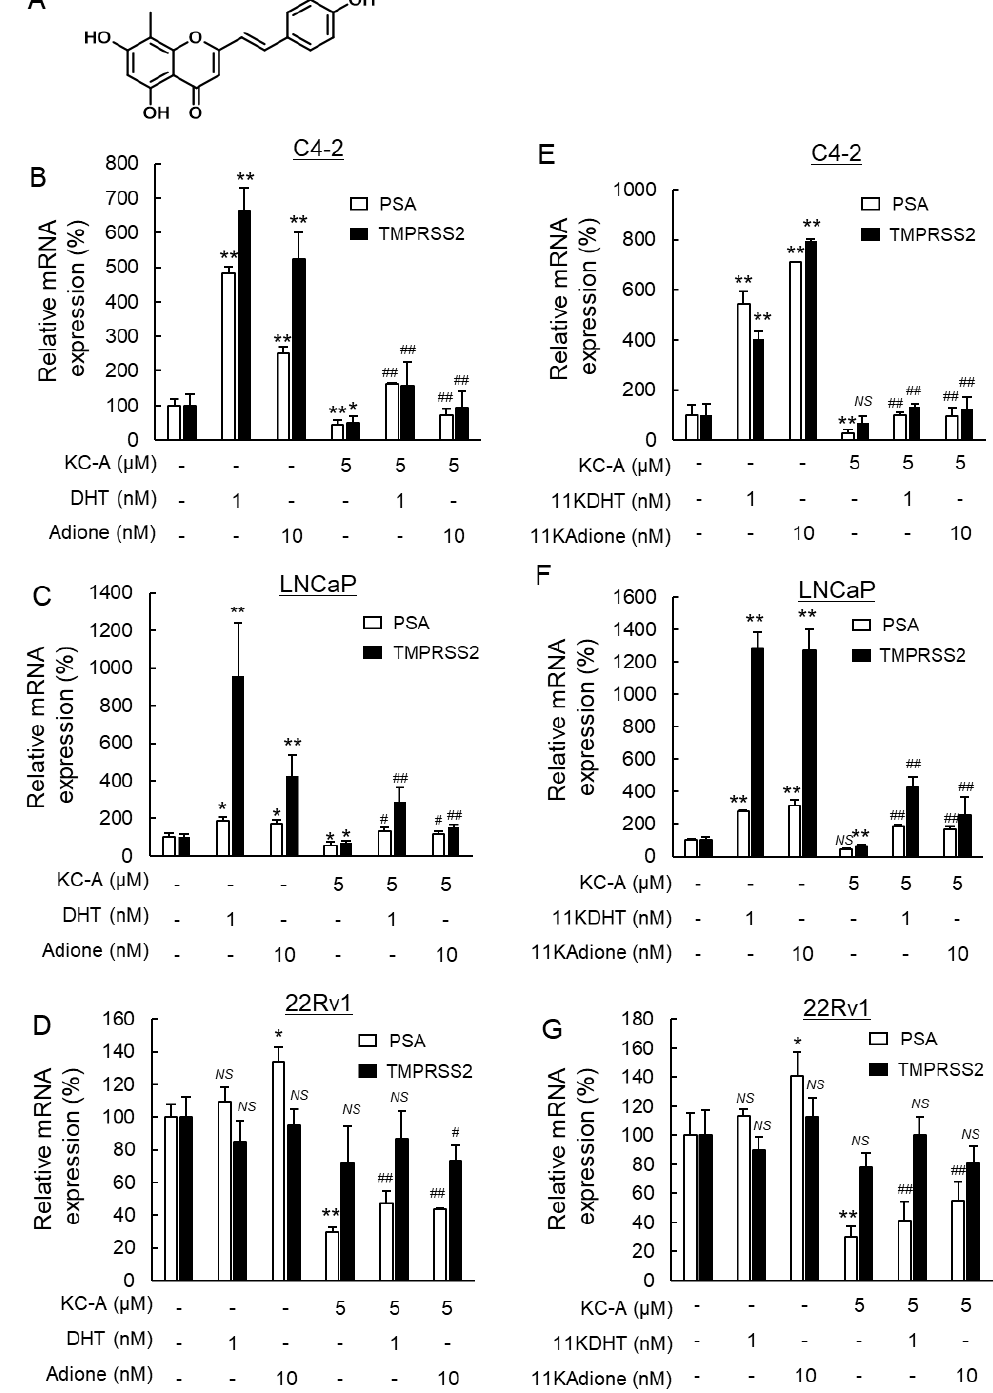
Figure 5. Structure of KC-A ( A ) and its effects on classic androgens and 11-keto-androgens regarding the induction of androgen signaling in C4-2 ( B , E ), LNCaP ( C , F ) and 22Rv1 ( D , G ) cells. The cells were pretreated for 2 h without or with 5 µ M KC-A, and then cultured for 24 h in the absence or presence of 1 nM DHT or 10 nM Adione ( B – D ), 1 nM 11KDHT or 10 nM 11KAdione ( E – G ). The mRNA expression levels were analyzed by RT-qPCR analysis. ** p < 0.01, * p < 0.05, NS p > 0.05 denotes significantly different from the cells treated with DMSO alone. ## p < 0.01, # p < 0.05, NS p > 0.05 denotes significantly different from the cells treated with 1 nM DHT, 10 nM Adione, 1 nM 11KDHT or 11KAdione alone.